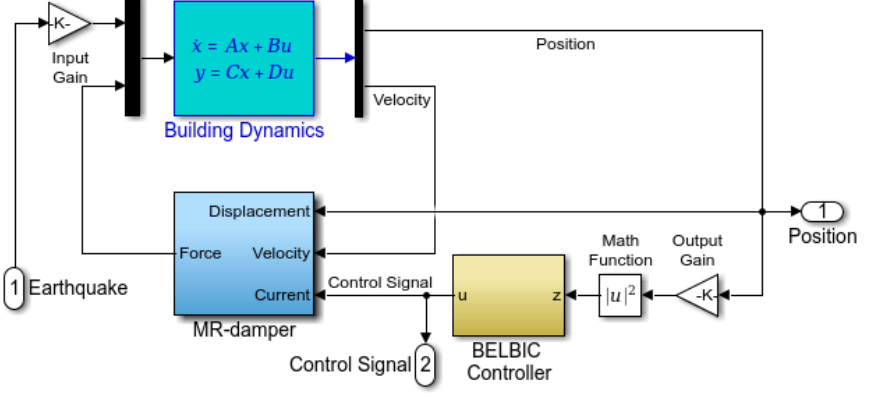
Figure 5. S IMULINK (cid:114) block diagram of the brain emotional learning (BEL)-based closed-loop control